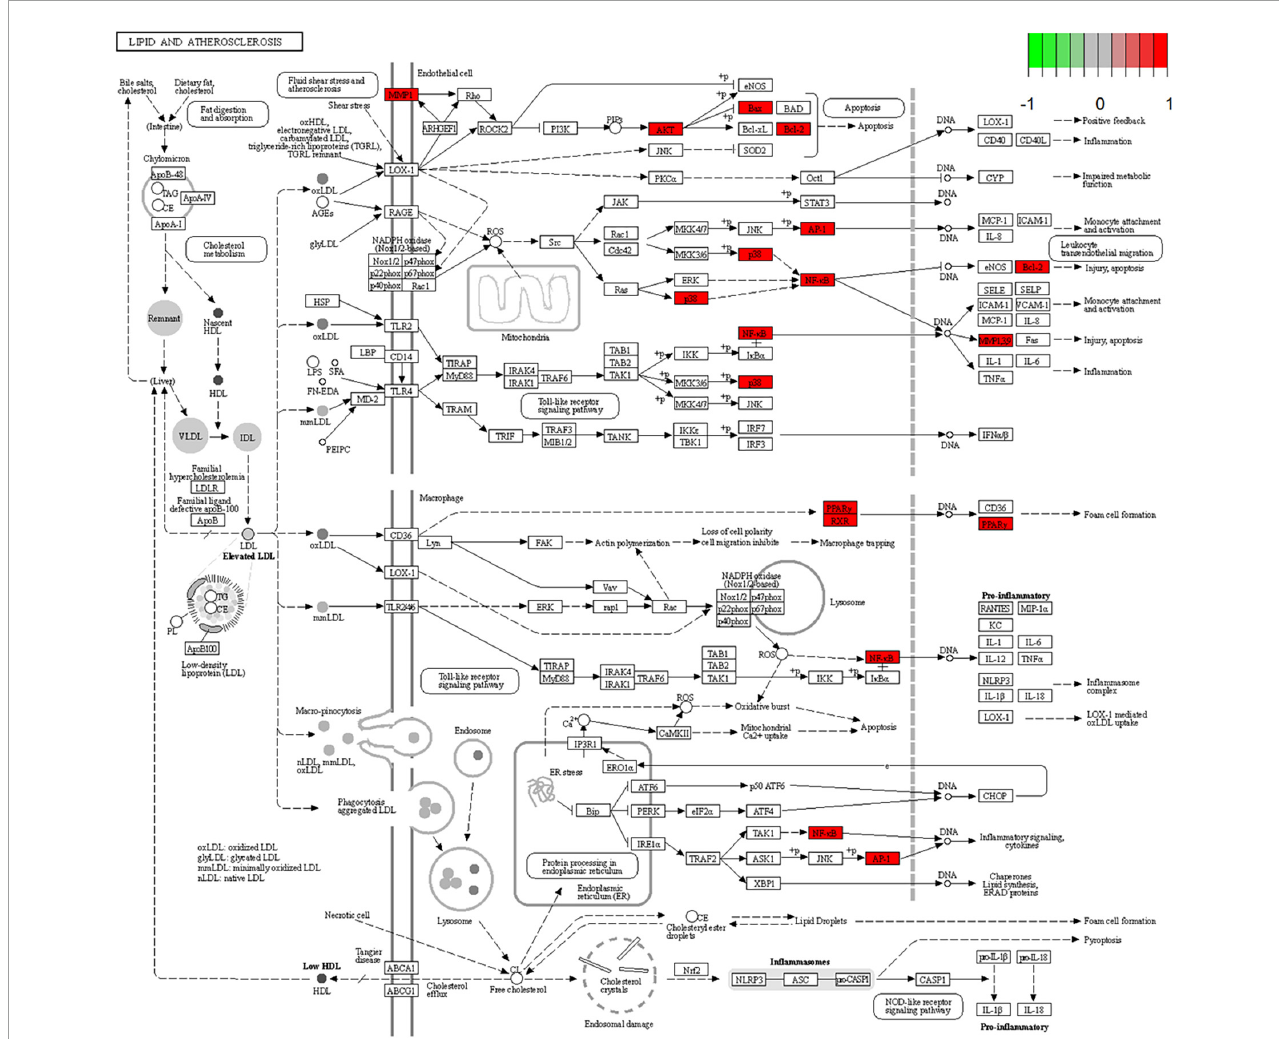
FIGURE6 Lipid and atherosclerosis signaling pathway. Red represents the intersection targets of THD against AS in the signaling pathway.